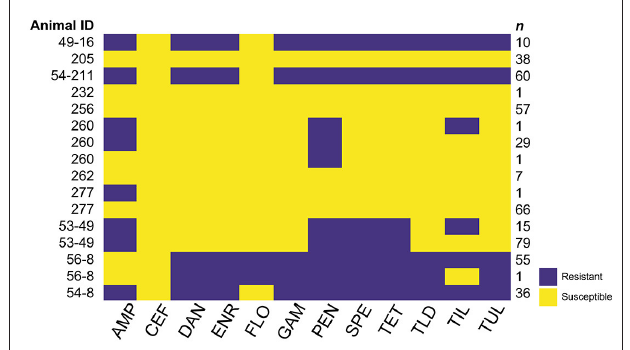
FIGURE 1 | Antimicrobial resistance (AMR) phenotypes (antibiograms) of M. haemolytica isolates from nasopharyngeal swabs (NSP) collected from 11 cattle. The median number (range) of M. haemolytica isolates obtained from each animal was 48 (1–94). Antimicrobials: ampicillin (AMP), ceftiofur (CEF), danofloxacin (DAN), enrofloxacin (ENR), florfenicol (FLO), gamithromycin (GAM), penicillin (PEN), spectinomycin (SPE), tetracycline (TET), tildipirosin (TLD), tilmicosin (TIL), and tulathromycin (TUL). Yellow cells indicate that the isolates were not resistant to the antimicrobial indicated, while purple cells indicate resistance. While multiple AMR phenotypes were identified among M. haemolytica isolates from four cattle (260, 277, 53–49, and 56–8), the difference in phenotype was in all cases due to a difference of only a single dilution in the broth microdilution assay, which led to the isolate changing from not resistant to resistant for only one or two antimicrobials. The relevant minimum inhibitory concentration (MIC) data are presented in Supplementary Material 1 .